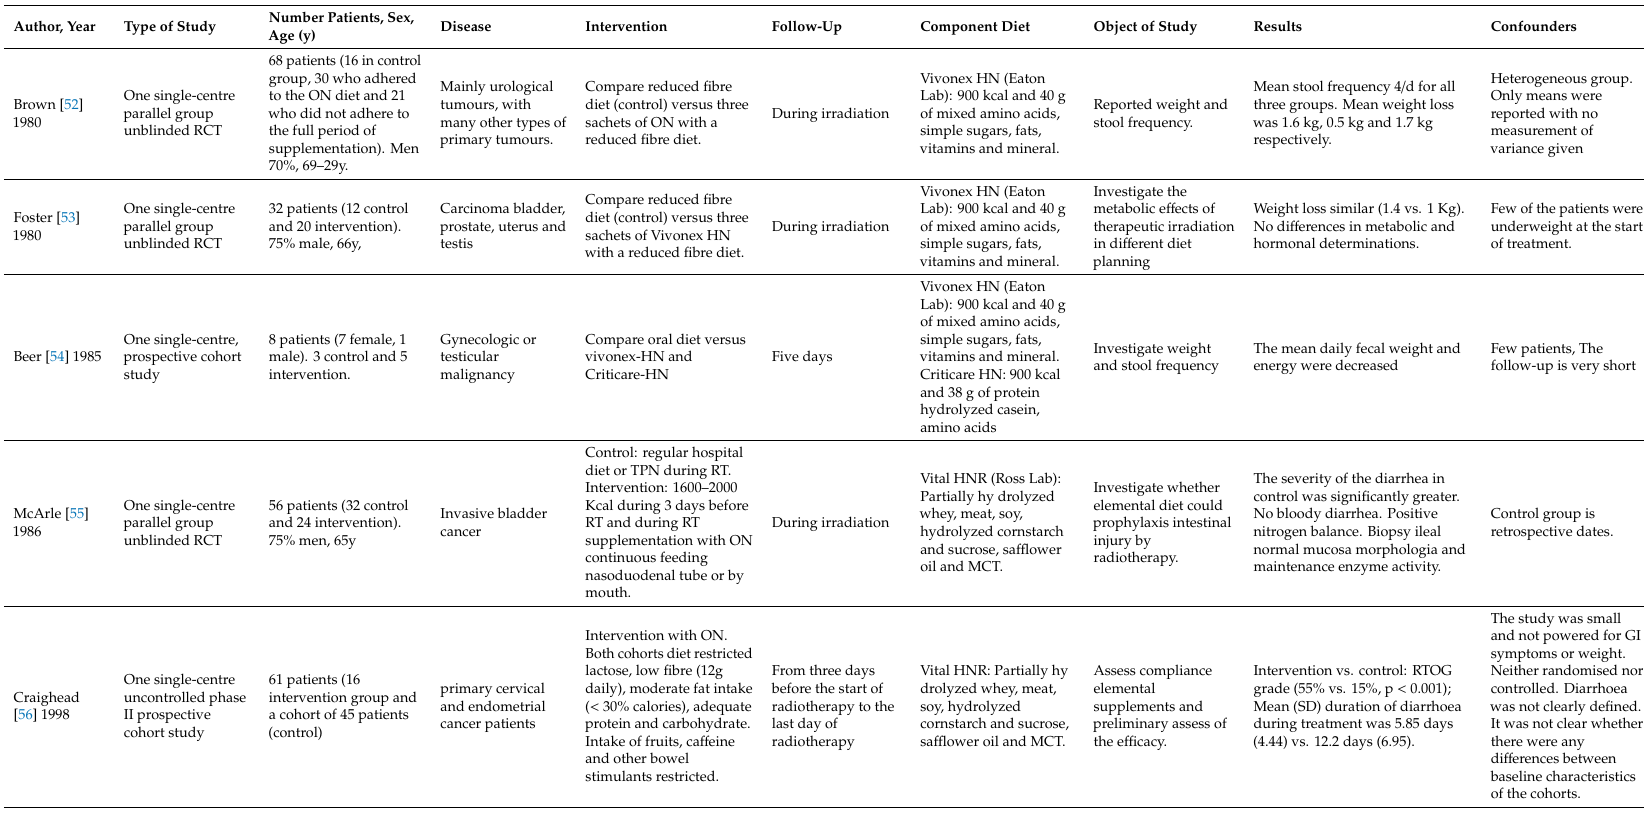
Table 2. Studies with oligomeric diet and Radiotherapy-induced oro-intestinal